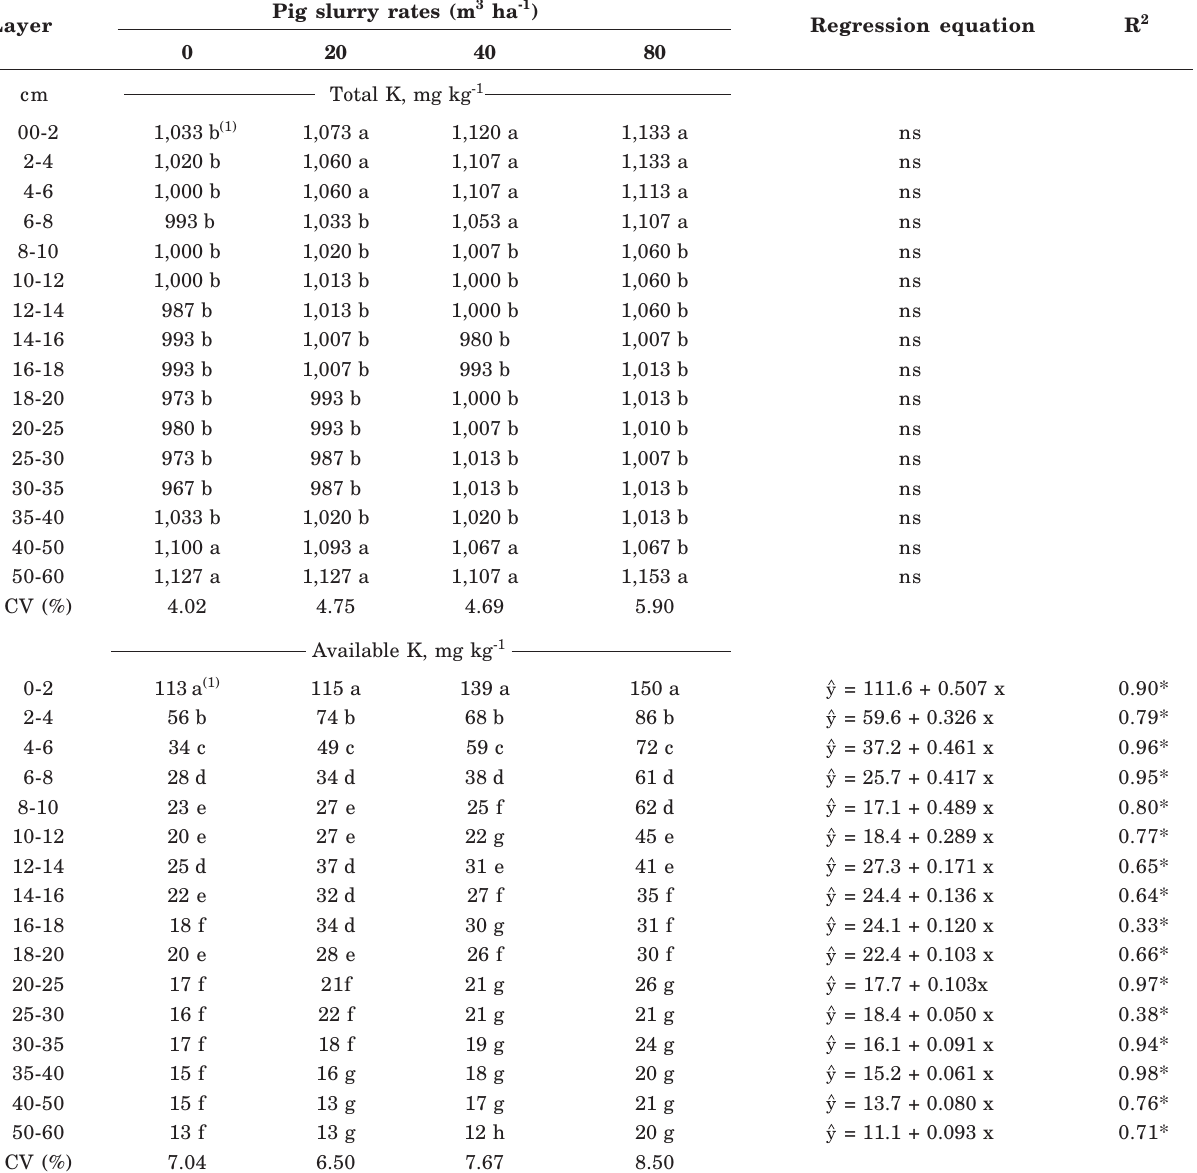
Table 5. Amounts of total and available potassium (K) in layers of Typic Hapludalf after 19 pig slurry